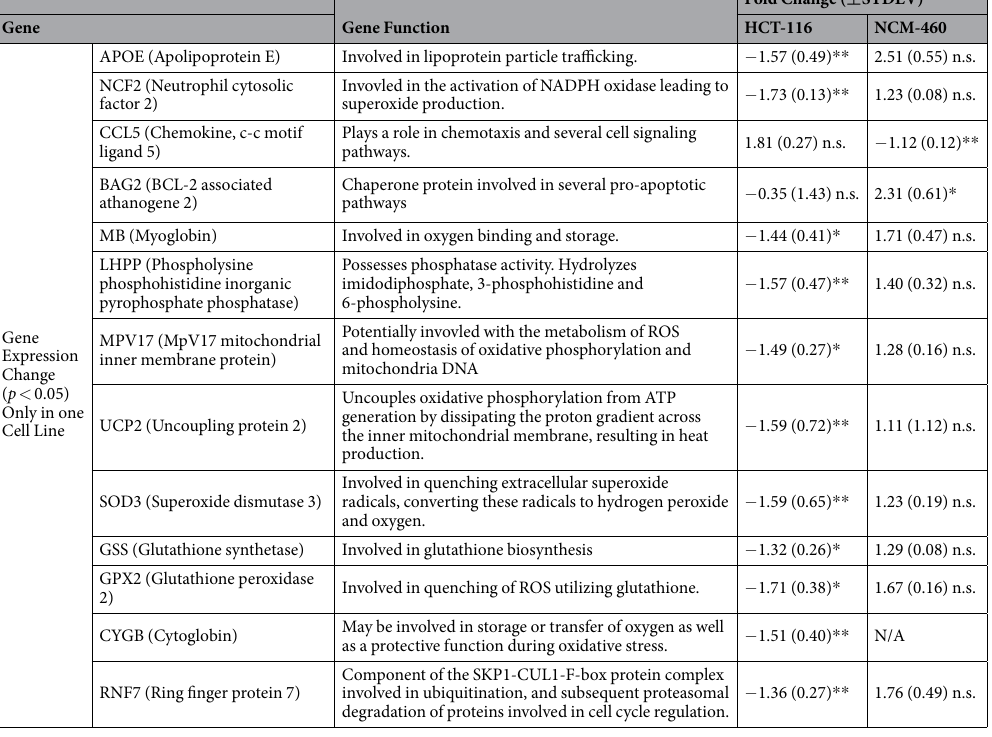
Table 6. Summary of the Relative-Fold Change in Gene Expression Utilizing RT 2 PCR. Statistical analysis was performed using One-Way ANOVA to relative-fold change of the control (1). * p < 0.05 vs control; ** p < 0.01 vs control; *** p < 0.001 vs control; **** p < 0.0001 vs control. n.s. = not significant, p > 0.05 vs control. N/A = not applicable due to no amplification detected. Gene function was obtained searching the UniProt or NCBI Gene